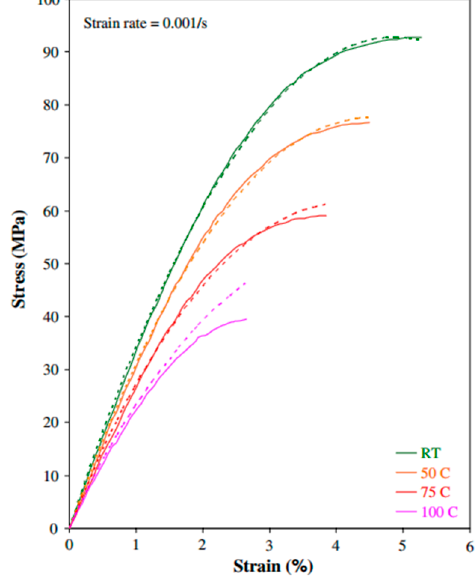
Figure 3. Tensile stress–strain curves for vinyl ester obtained from experiment and standard linear solid model, at a strain rate of 0.001/s and different temperatures. Reprinted with permission from Ref. [31], [Deformation response and constitutive modeling of vinyl ester polymer including strain rate and temperature effects]; published by [J. Mater. Sci], year [2008]. Table 5. Modules of vinyl ester at a wide range of temperatures. Data are extracted from Figure 3. Elastic Modulus of Vinyl Ester (GPa)